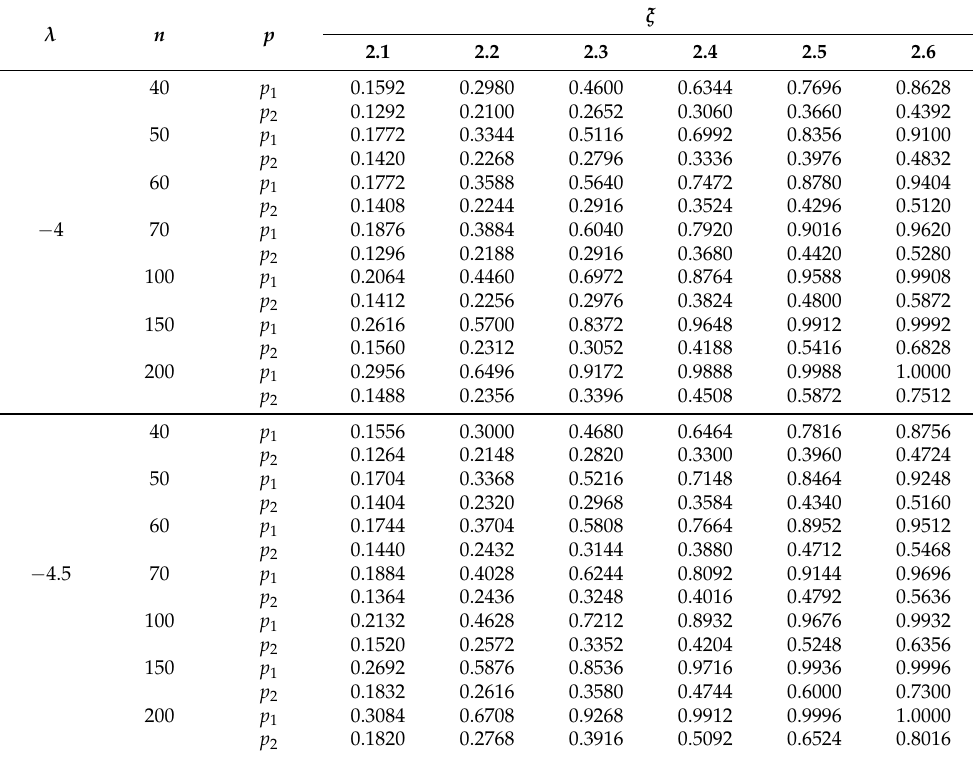
Table A3. Simulated powers of hypothesis testing problem (19) (negative